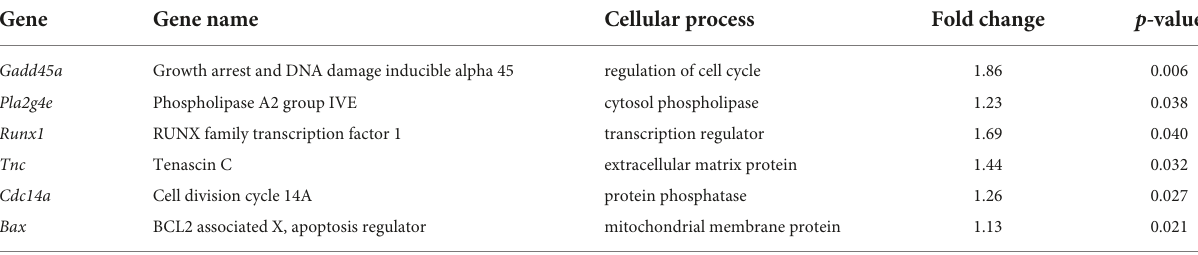
TABLE 1 Genes that were significantly higher in ketone ester (KE) compared to control (CON).